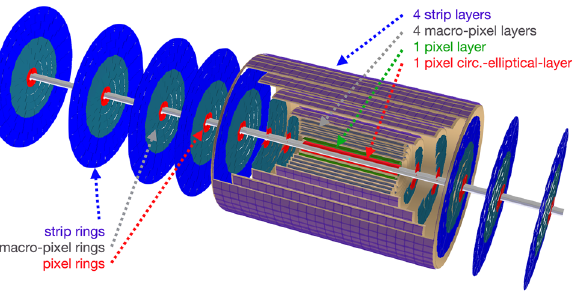
Fig. 5 Structure of the Silicon tracker for the LHeC detector